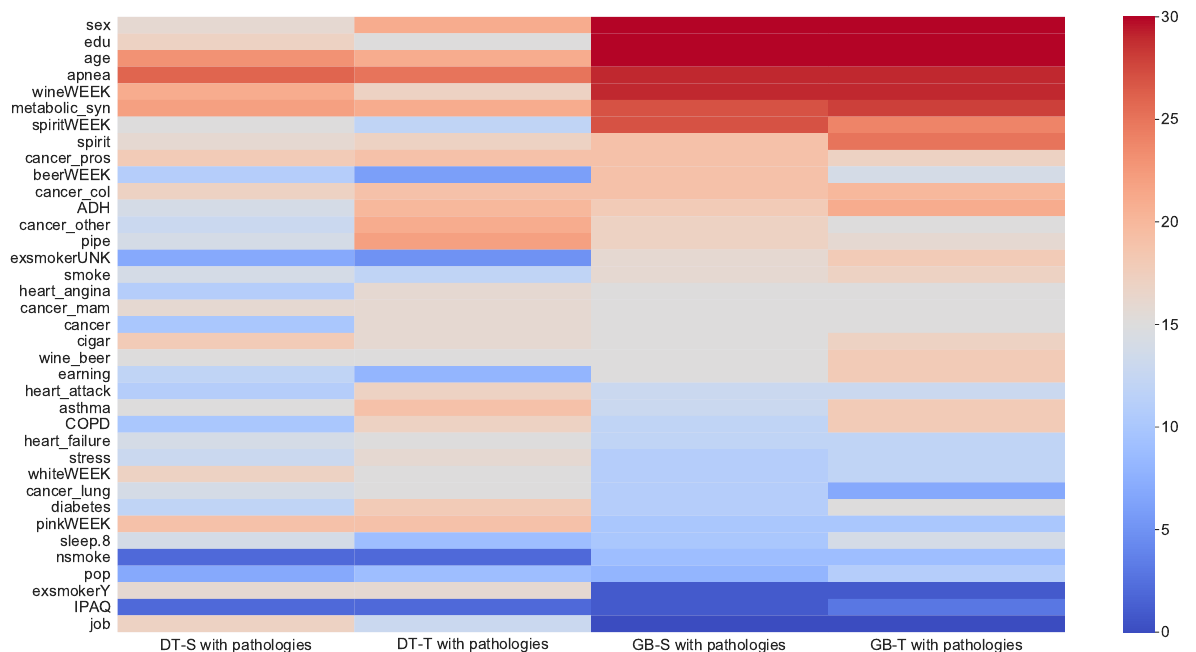
Figure 6. Heat map for frequency of the different variables using FS with GA, dataset with